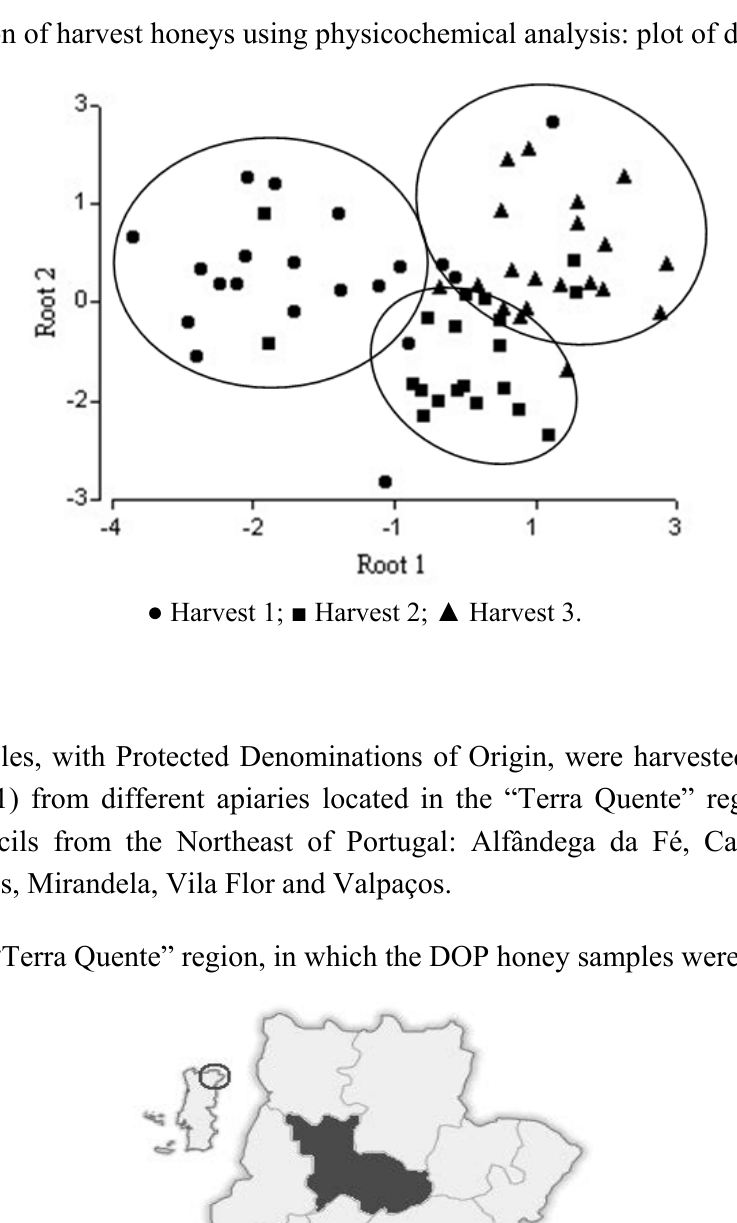
Figure 4. Separation of harvest honeys using physicochemical analysis: plot of discriminant scores.